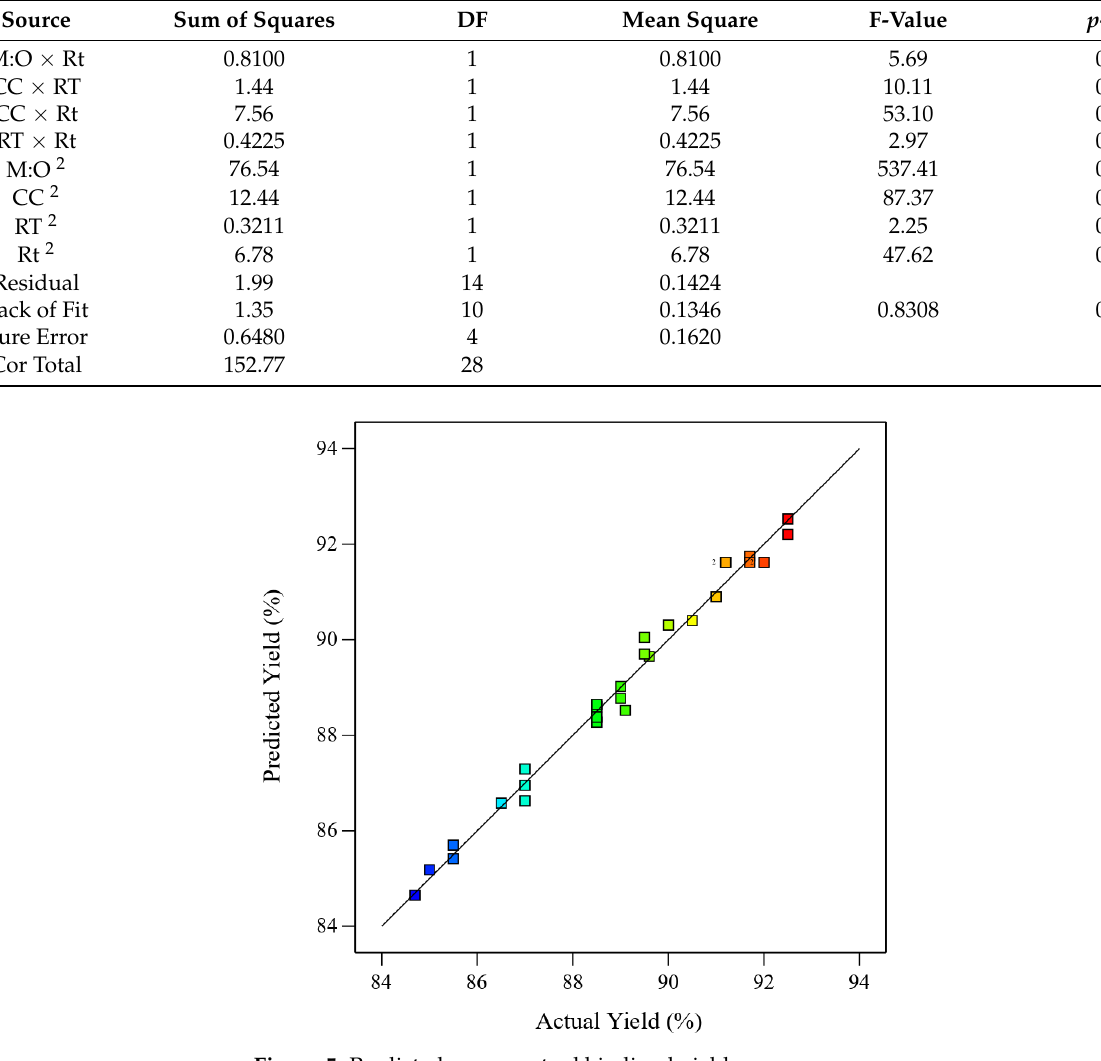
Figure 5. Predicted versus actual biodiesel yield. Table 5. Analysis of variance for biodiesel yield.